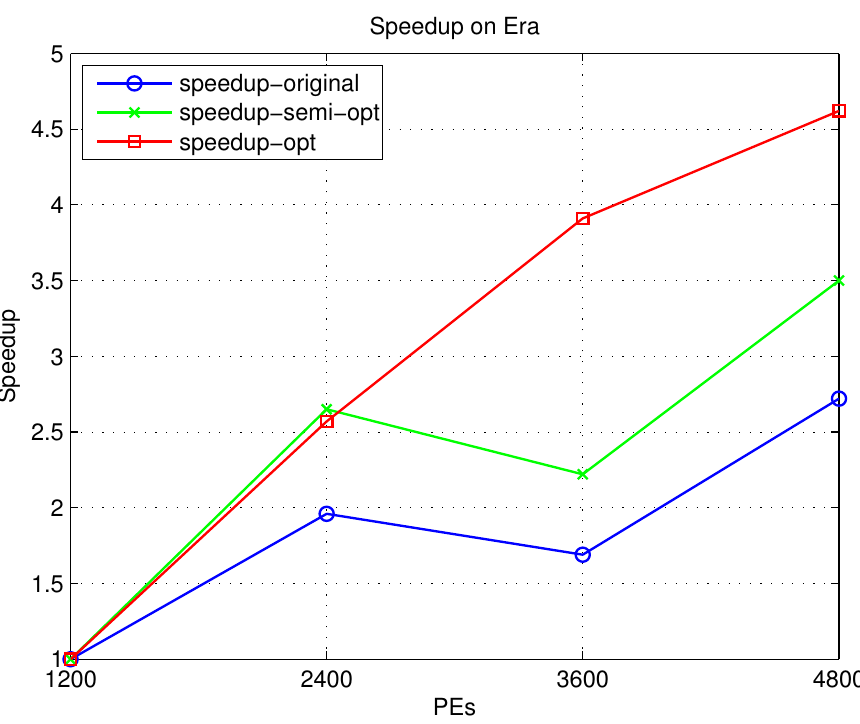
Figure 7. Speedup of LICOM on Era.